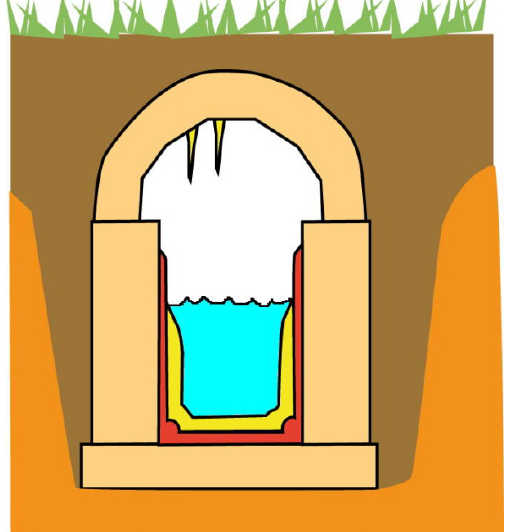
Figure 10. Typical cross-section of a Roman aqueduct channel. The channel is built of masonry, and lies in an excavation in the soil. The inside is covered with a red waterproof cement ( opus signinum —in red), with characteristic quarter rounds to seal the edges. Carbonate deposits (yellow) are common in some